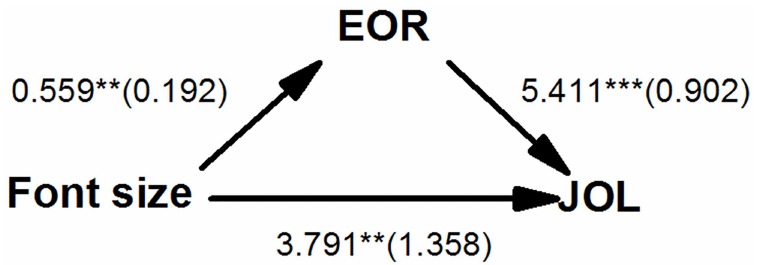
Fig 1. Regression coefficients (and standard errors) for the effect of font size on EORs and effects of font size and EORs on JOLs. JOL = judgment of learning, EOR = ease of reading judgment. (cid:3)(cid:3)(cid:3) p < 0.001, (cid:3)(cid:3) p < 0.01, (cid:3) p <